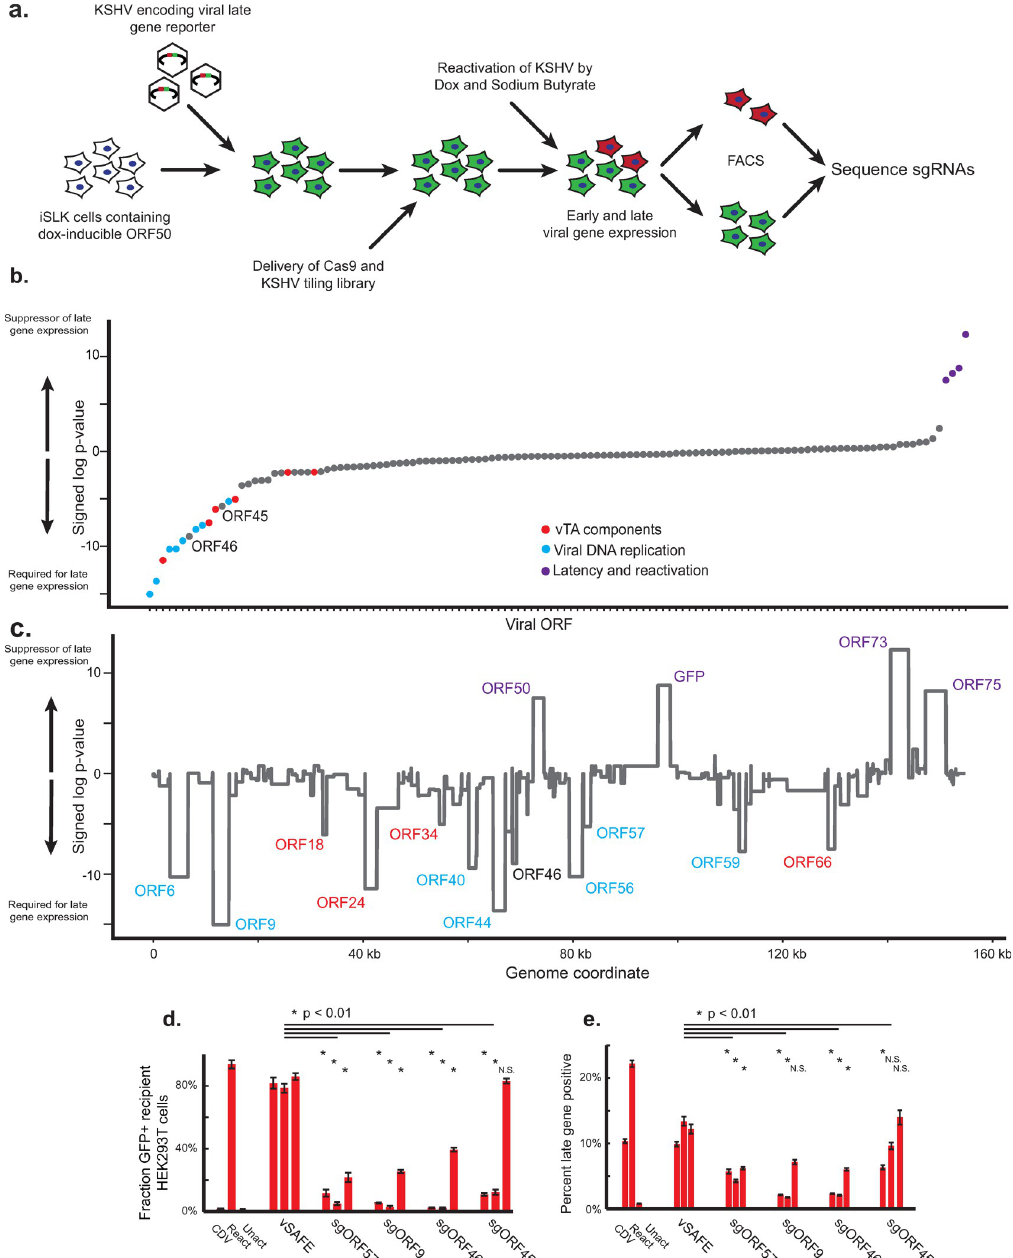
Fig 2. Pooled tiling screen of KSHV genome for modifiers of late gene expression. a) Design of viral tiling screen for late gene expression. iSLK cells were infected with KSHV encoding a far-red reporter of late-gene activity. Cells were lentivirally infected with Cas9-blast and subsequently the KSHV tiling sgRNA library. After 1–2 weeks of latency to allow for editing, cells were reactivated into the lytic cycle by doxycycline and sodium butyrate. 48 hours post reactivation, cells were trypsinized, fixed, and sorted for high and low late-gene expression. The sgRNA locus in each population was then sequenced to calculate enrichment. b,c) To calculate significance, sgRNAs targeting each annotated region of the genome were grouped and a signed log Mann-Whitney p-value was calculated comparing each viral region to the negative control sgRNAs using an average enrichment from two replicates. Viral ORFs sorted by significance (b) or genome location (c). A positive log p-value indicates this region promotes late gene expression when disrupted, and a negative log p-value indicates this region is required for expression of late genes. d,e) Three independent sgRNAs from the screen targeting each indicated ORF were individually cloned and delivered to late-gene reporter iSLK cells. Virion production was measured by supernatant transfer to uninfected HEK293T cells (d) and late-gene reporter activity (e). Error bars are standard error from three independent reactivations. Activated, unreactivated, and parent samples treated with the viral DNA replication inhibitor cidofovir (CDV) were included